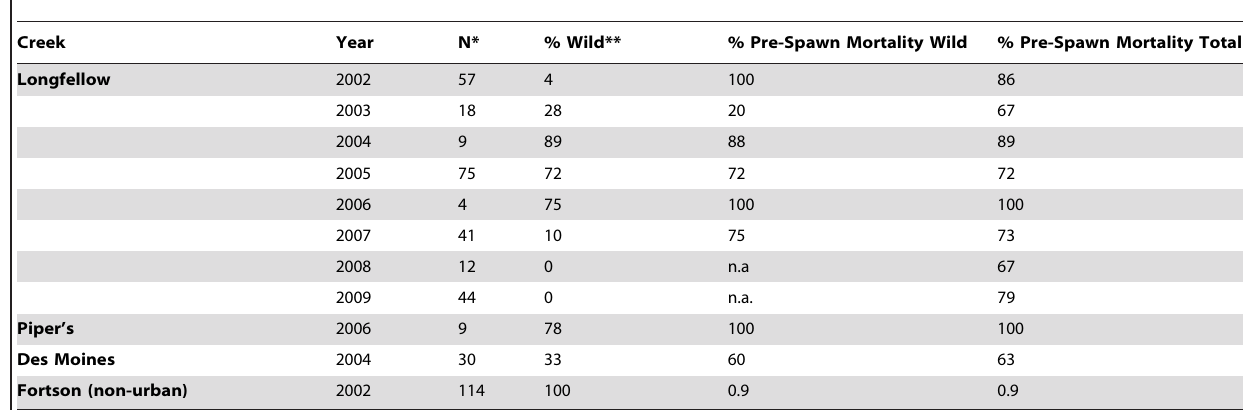
Table 2. Rates of coho pre-spawn mortality in Puget Sound lowland streams surveyed daily from 2002–2009.